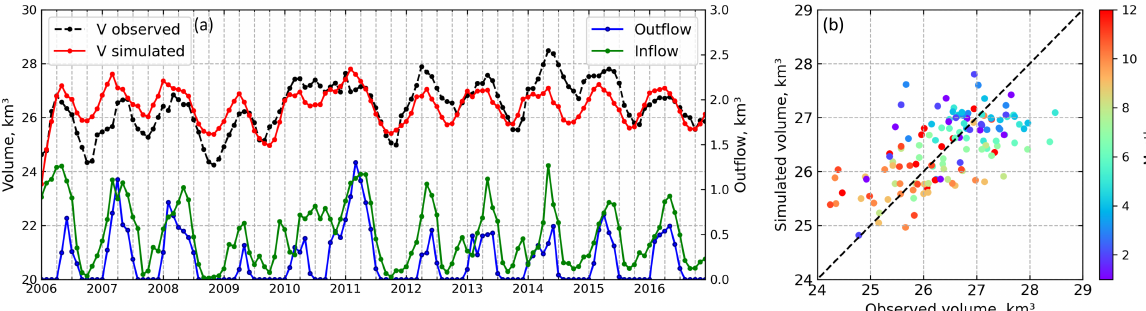
Figure 3. Results of water balance model validation (2006–2017) along with simulated outflow and inflow values given in monthly resolution ( a ). Scatter diagram of the validation results ( b